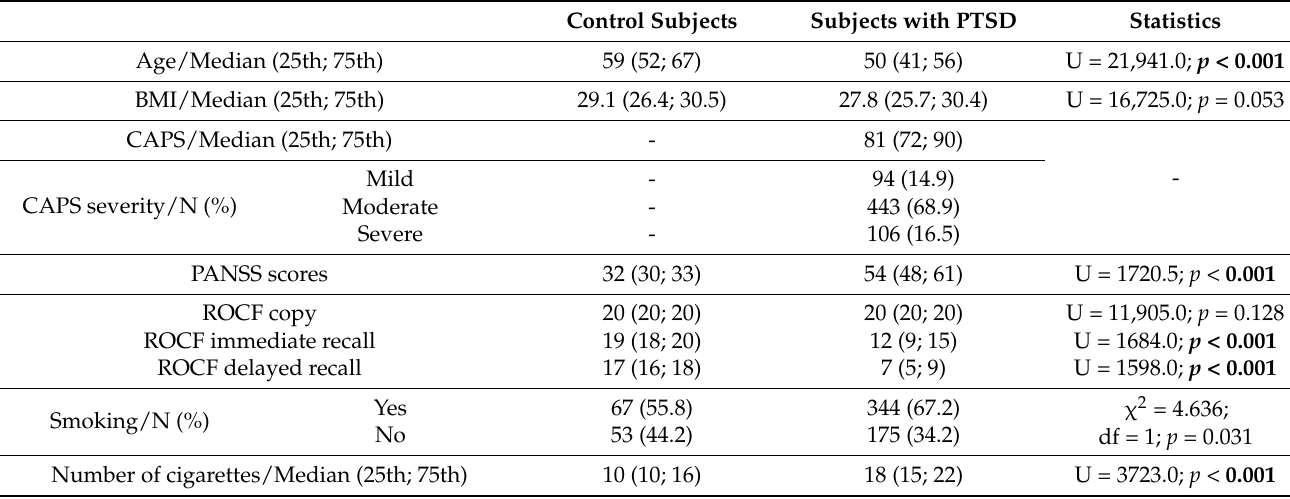
Table 1. Demographic and clinical data of 121 control subjects and 643 subjects with PTSD. The data are shown as the median and interquartile range (25th; 75th percentile) or as total number N (frequency in percentages). p values in bold represent statistical significance. Control Subjects Subjects with PTSD